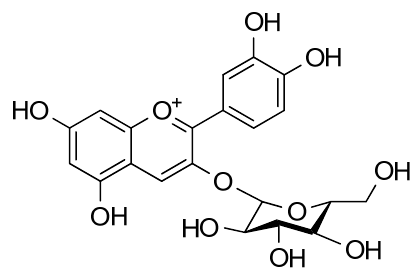
Figure 3. Structure of